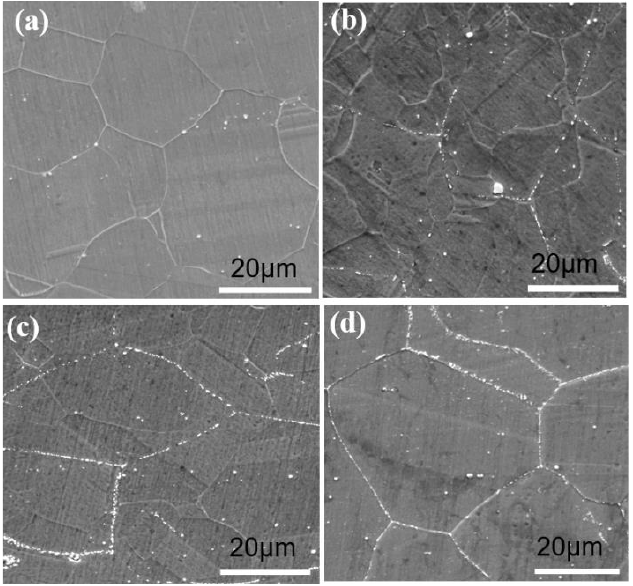
Figure 19. The precipitation of second-phase particles at different temperatures: ( a ) as-received status; ( b ) 800 °C; ( c ) 900 °C; ( d ) 1000 °C.